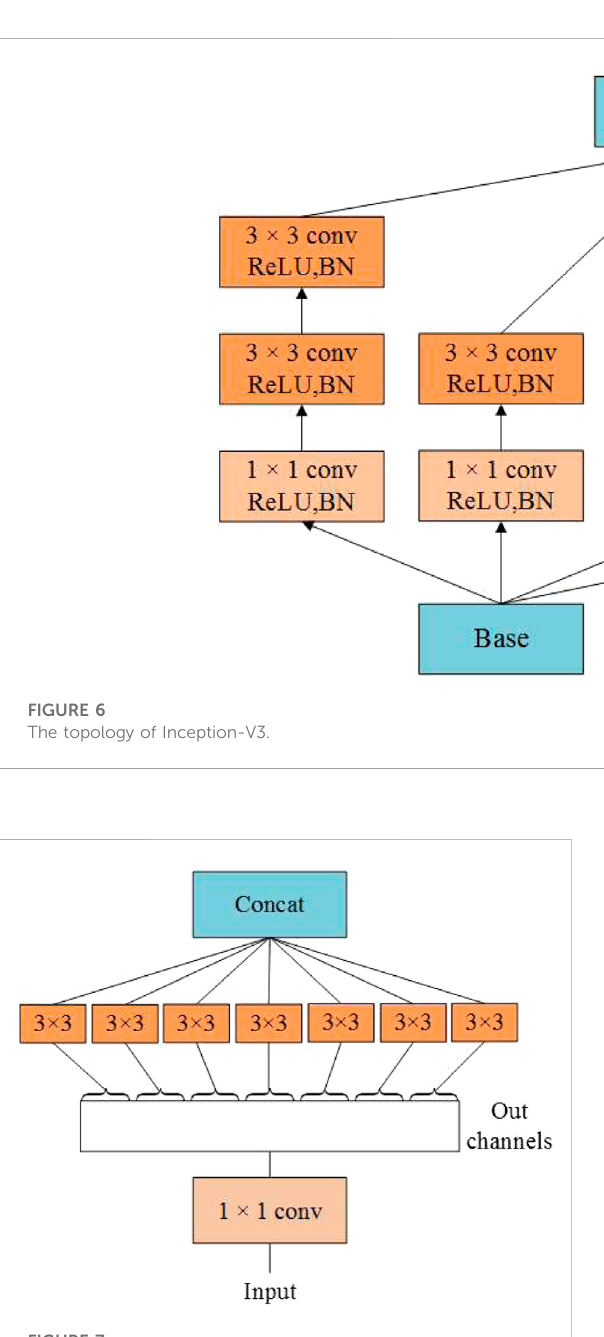
FIGURE 7 Perform the 3 × 3 convolution on each channel of the 1 × 1